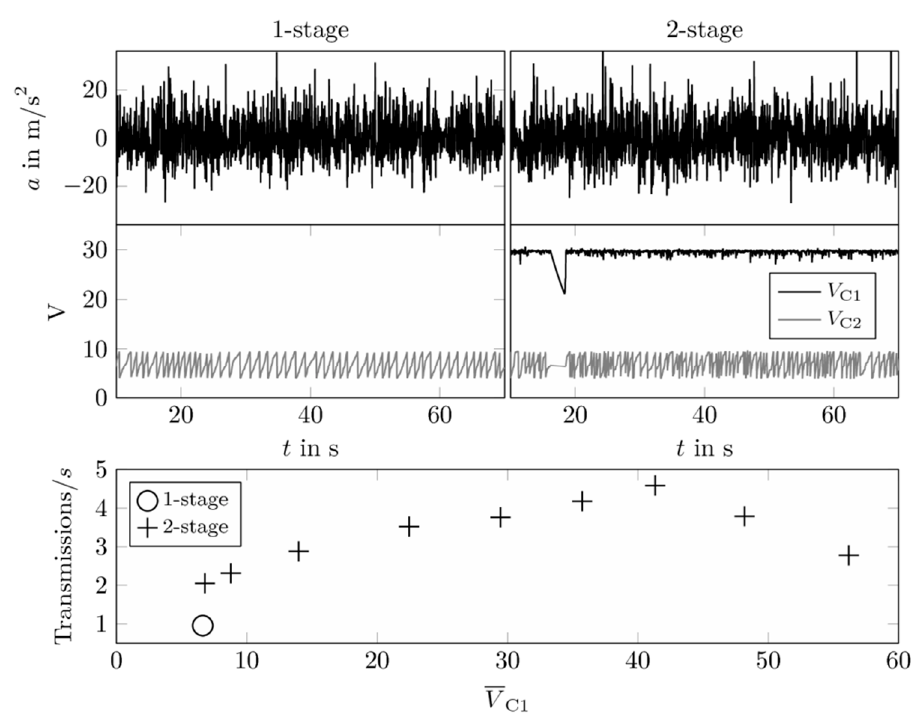
Figure 5. Practical evaluation and comparison of the single- and two-stage energy extraction